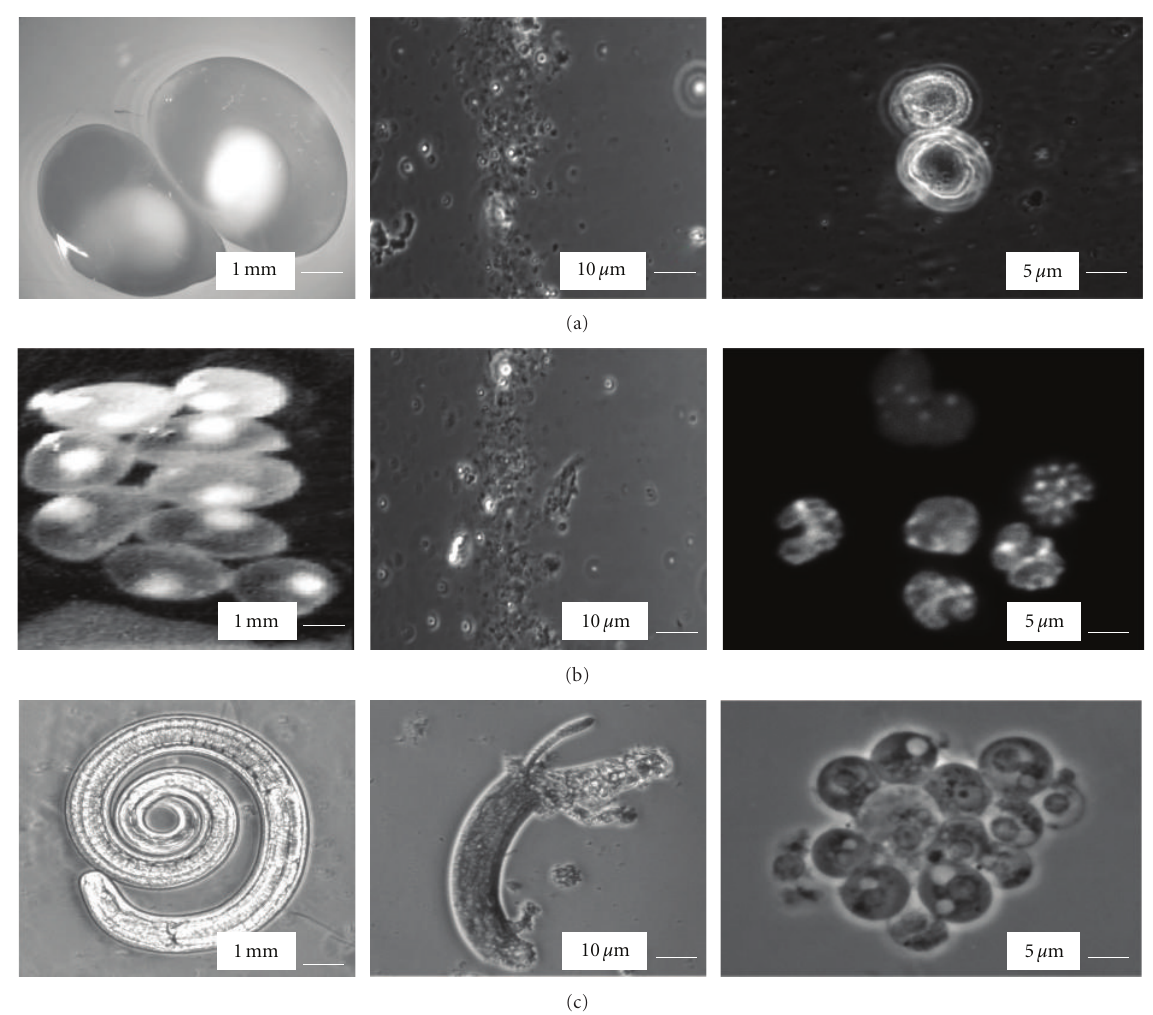
Figure 1: Imaging of the process of getting single cells from T. solium , T. crassiceps , and T. spiralis after mechanical disaggregation. (a) T. solium cysticerci (first picture), pieces of T. solium after disgregation (middle picture), and T. solium isolated cells (third picture of panel (a)). In (b) T. crassiceps (first picture), pieces of T. crassiceps after disaggregation (middle picture), and T. crassiceps isolated cells (third picture of panel (b)) and (c) Trichinella spiralis (first picture), pieces of T. spiralis after disaggregation (middle picture) and T. spiralis isolated cells (third picture of panel (c)). Pictures were taken using an inverted microscope (Olympus, MO21, Tokyo) at 10x and 100x